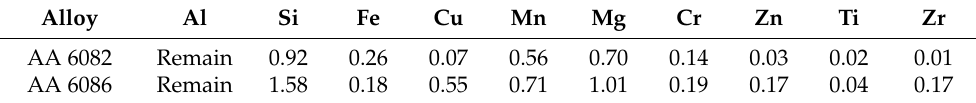
Table 2. The chemical composition of the alloy AA 6086 in wt.%. as determined by ICP-OES